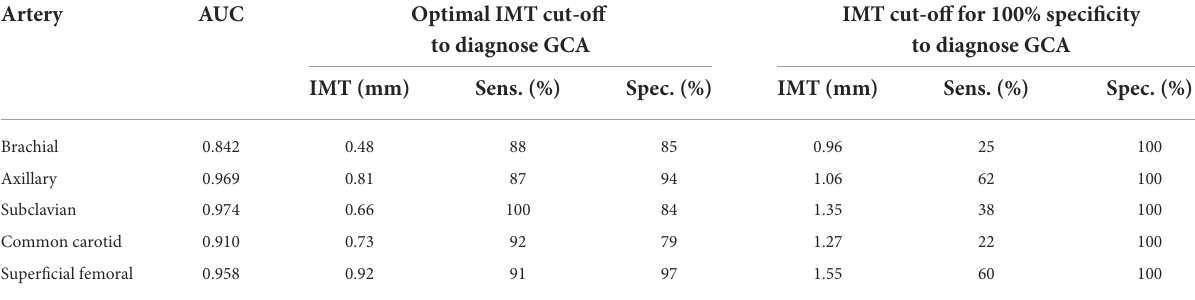
TABLE 5 Cut-off values for IMT depicting vasculitis in patients with GCA vs. controls.